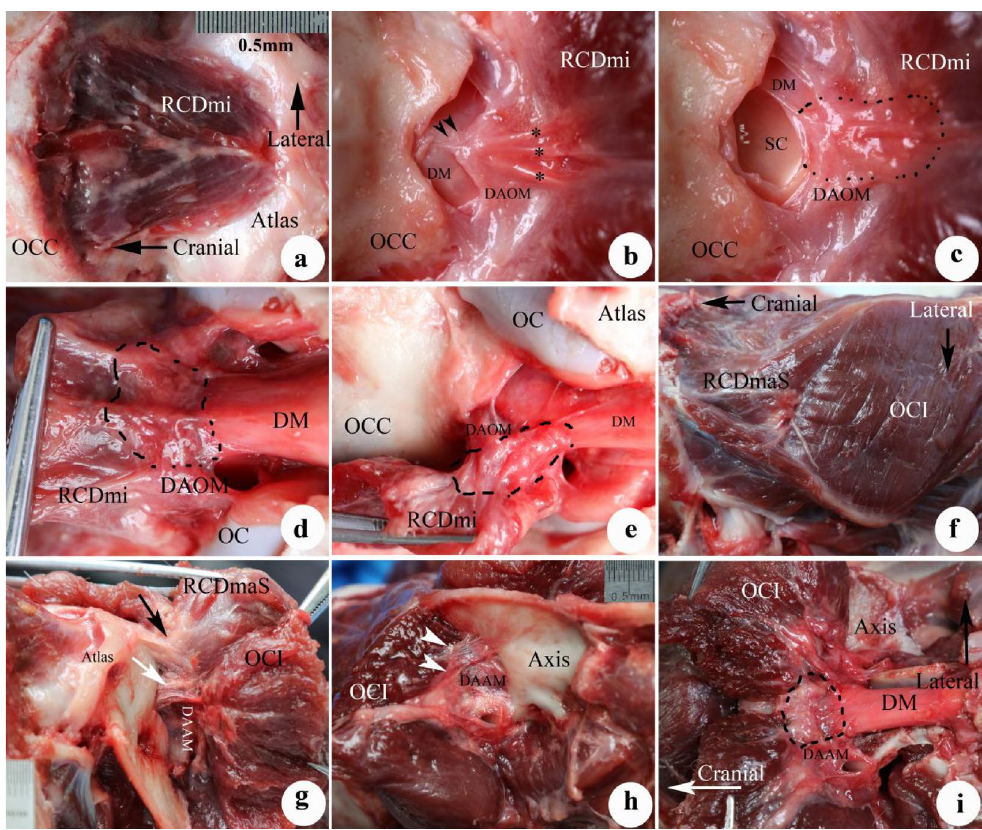
Figure 3. The MDB at the dorsal atlanto-occipital or atlanto-axial interspaces. The RCDmi overlay the dorsal atlanto-occipital interspace (Fig. 3a). When the RCDmi was reflected and stretched caudally the DAOM was severed along the posterior margin of occipital bone, and a fibrous connection was observed between the RCDmi and the DAOM (trigeminy stars), and also between the DAOM and the SDM (double arrowheads) (Fig. 3b). After the DM was cut along the margin of foramen magnum, and the RCDmi was reflected caudally, it was found that the DM was stretched dorsally via the MDB (enclosed by the dotted line) (Fig. 3c). On the other hand, the connective tissues (enclosed by the dotted line) among the RCDmi, the DAOM, and the DM were observed from the caudal side when the posterior arch of the atlas and the vertebral lamina were removed and the RCDmi was reflected to the cephalic side (Fig. 3d). At the lateral side of the dorsal atlanto-occipital interspace, the posterior arch of the atlas and the vertebral lamina of the axis were removed and the RCDmi was reflected laterally, and the connective tissues (enclosed by the dotted line) among the RCDmi, the DAOM, and the DM were again observed (Fig. 3e). Between the atlas and axis, the short head of the RCDma (RCDmaS) and the OCI passed over the dorsal atlanto-axial interspace (Fig. 3f). The fibrous connections between the OCI and the DAAM (white arrow), and between the short head of the RCDma and the DAAM (black arrow) were exposed in cranial aspect (Fig. 3g) and in the caudal aspect (double arrowheads) (Fig. 3h). After the lamina of the axis was removed and the OCI was reflected cranially, the dense connective tissue (enclosed by the dotted line) among the OCI, DAAM, and DM was observed (Fig. 3i). OCC: Occipital bone, RCDmi: Rectus capitis dorsal minor, DAOM: Dorsal atlanto-occipital membrane, DM: Dura mater, SC: Spinal cord, MDB: